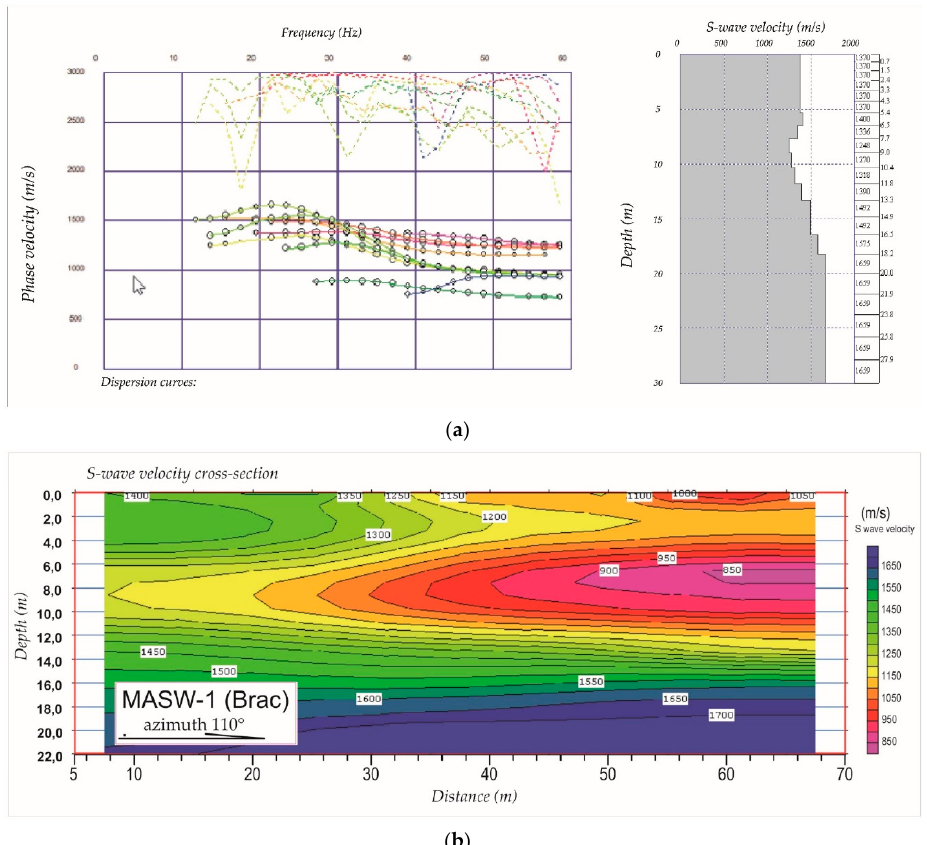
Figure 9. Shear wave velocity model obtained by the multichannel analysis of surface waves (MASW) seismic method. ( a ) Phase velocity curves with corresponding signal-to-noise curves on the left side and corresponding shear velocity 1D profile on the right side. ( b ) S-velocity model obtained using the Seisimager CMP technique, OYO Corporation.